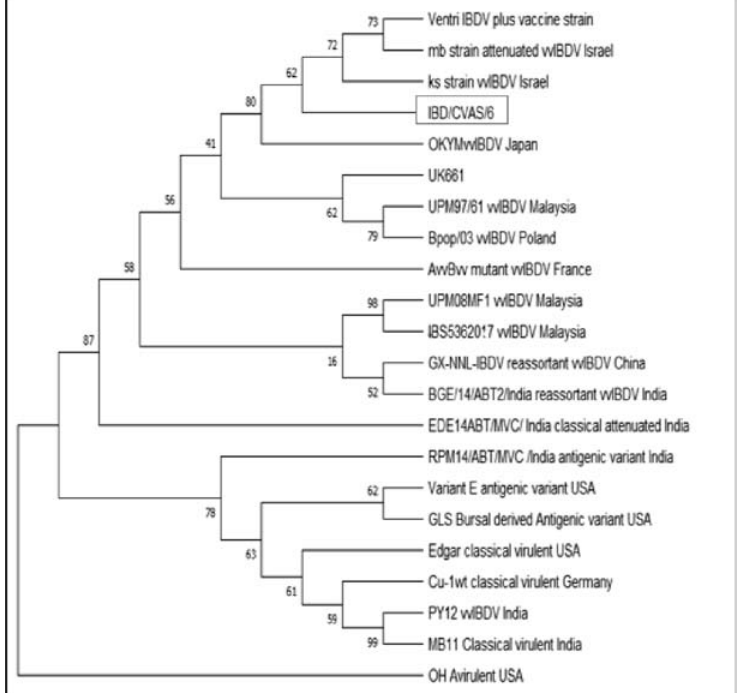
Fig.7. Phylogenetic tree based on the analysis of 705 bp nucleotides of VP3 gene importance of considering a more advanced vaccination strategy, which could provide a fairly safe and efficient protective umbrella for the susceptible birds against